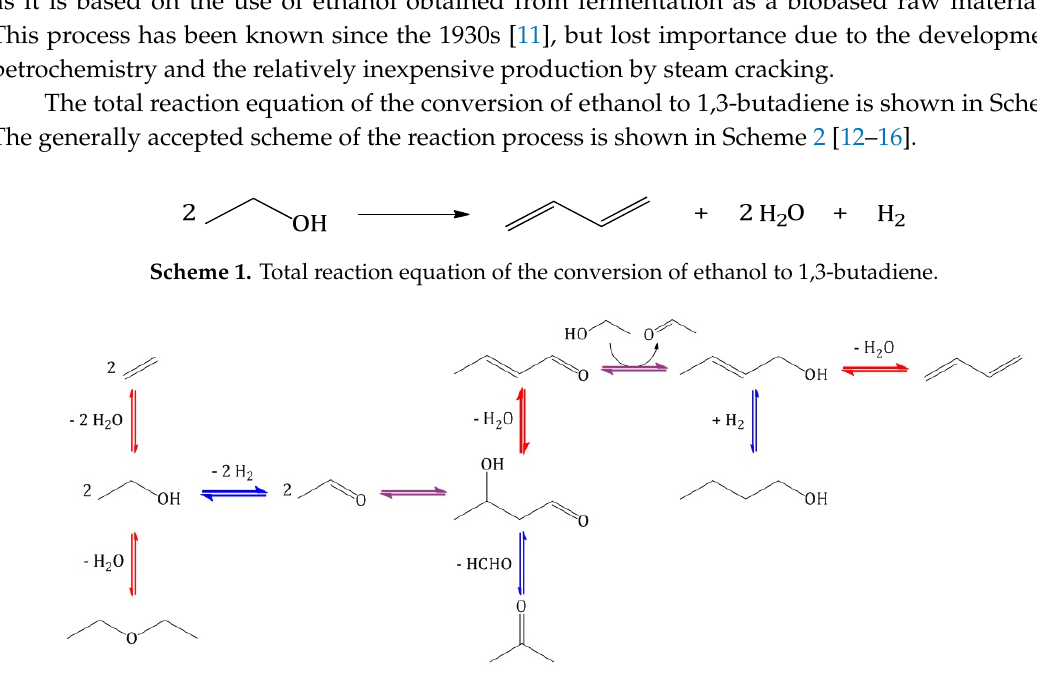
Scheme 2. Reaction scheme of the conversion of ethanol to 1,3-butadiene. Blue arrows: basic catalyzed reaction. Red arrows: acidic catalyzed reaction. Violet arrows: acidic and/or basic catalyzed reaction.